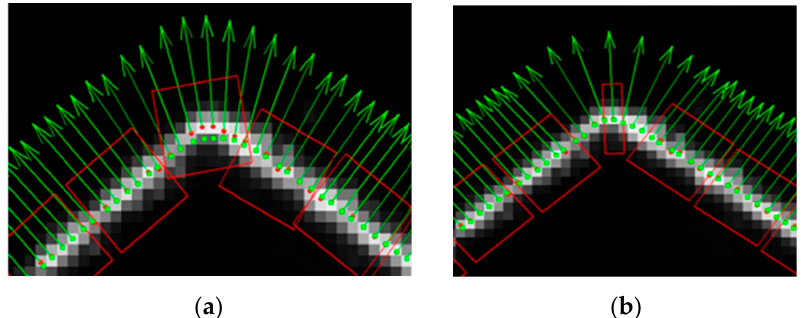
Figure 5. Center extraction at a sharp corner: ( a ) using rectagular regions with fixed width; ( b ) using rectagular regions with adaptive width.